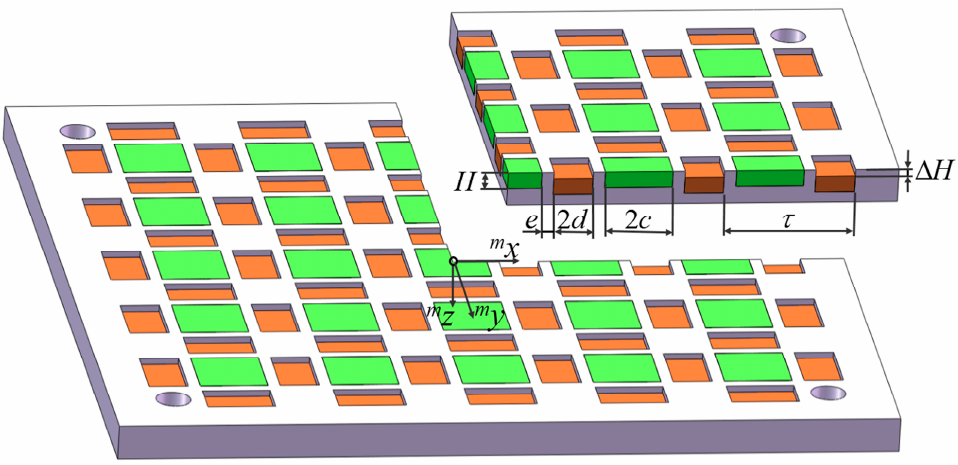
Figure 1. Sectional view of the novel magnet array with gaps and staggers.